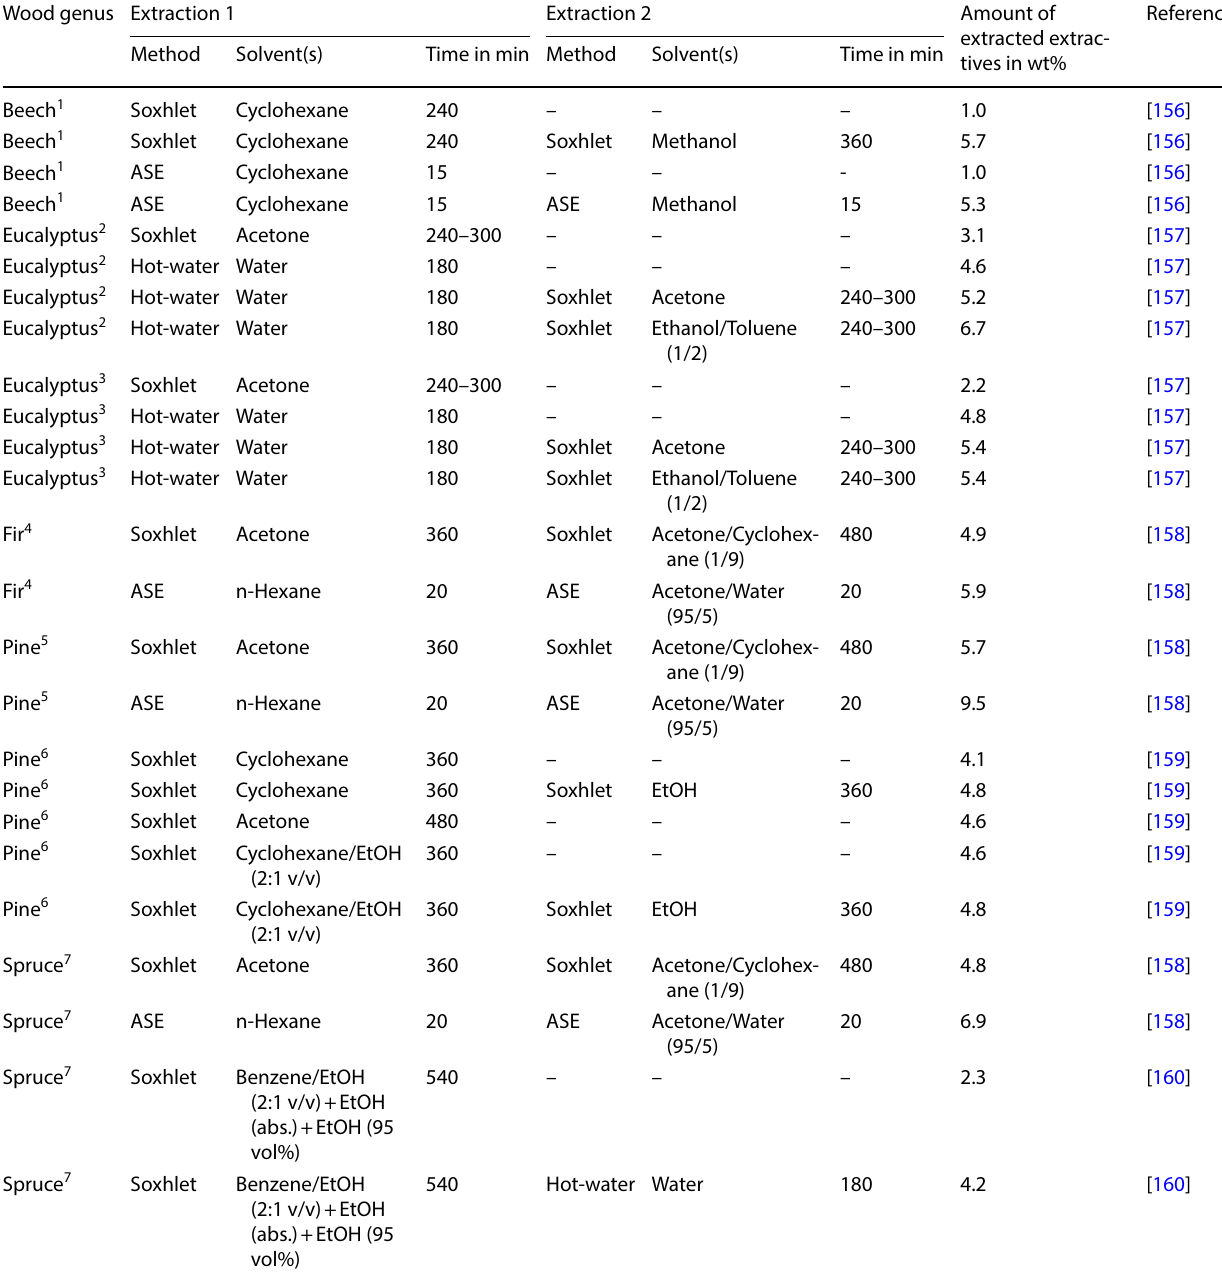
Table 3 Lab scale extractions of groundwood with different methods and solvents